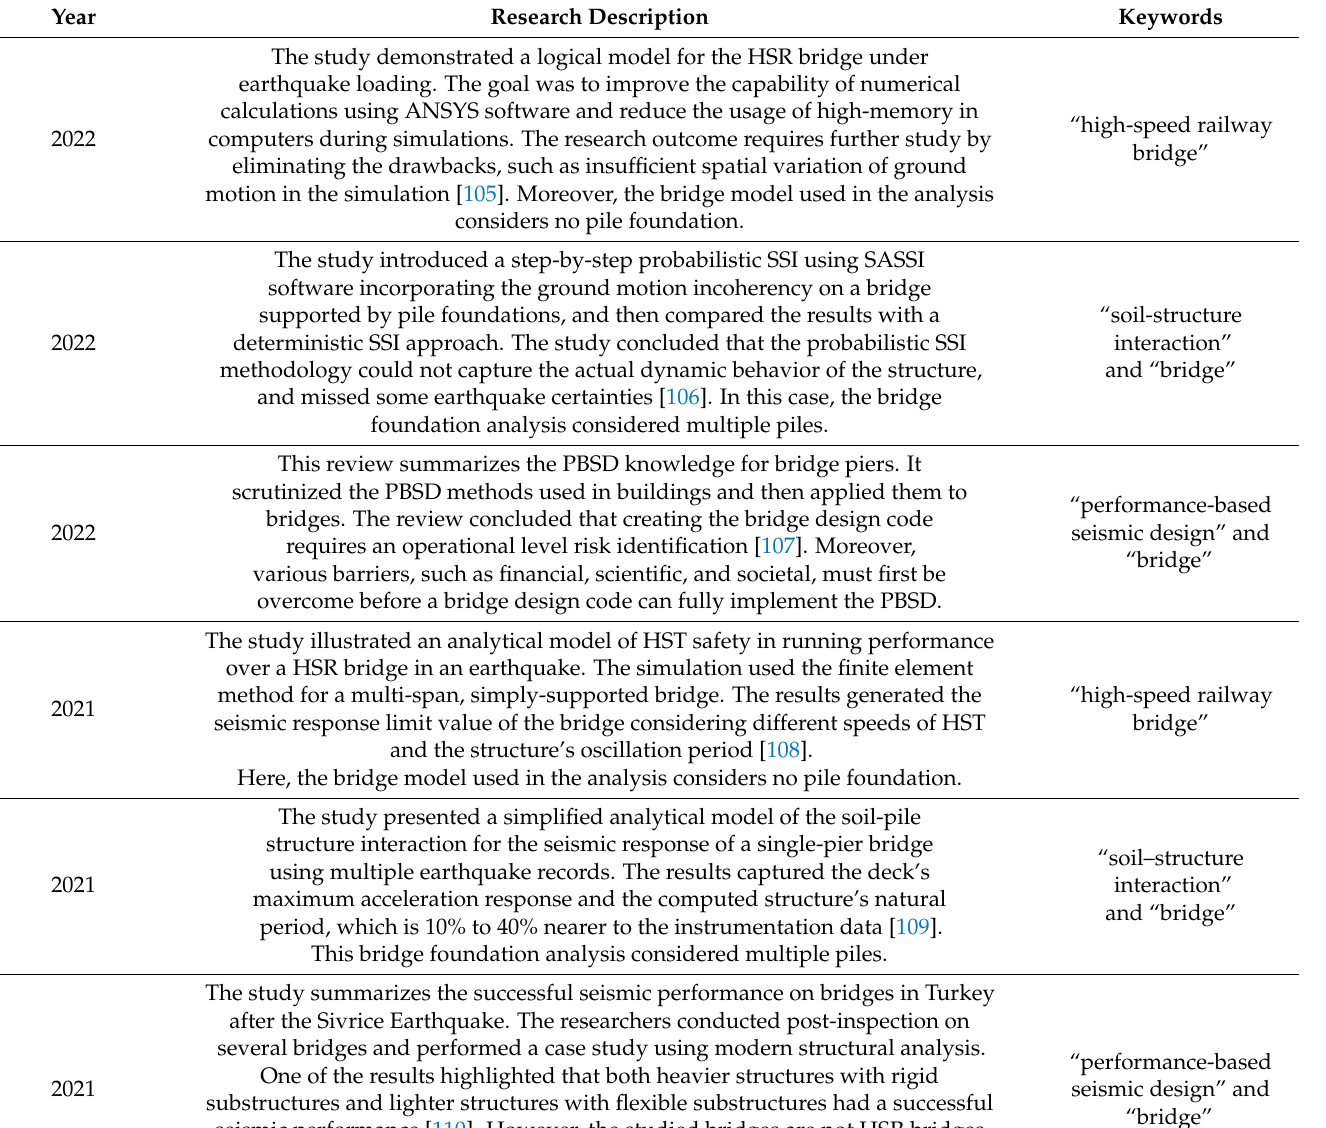
Table 7. Extraction of information from latest studies on bridge